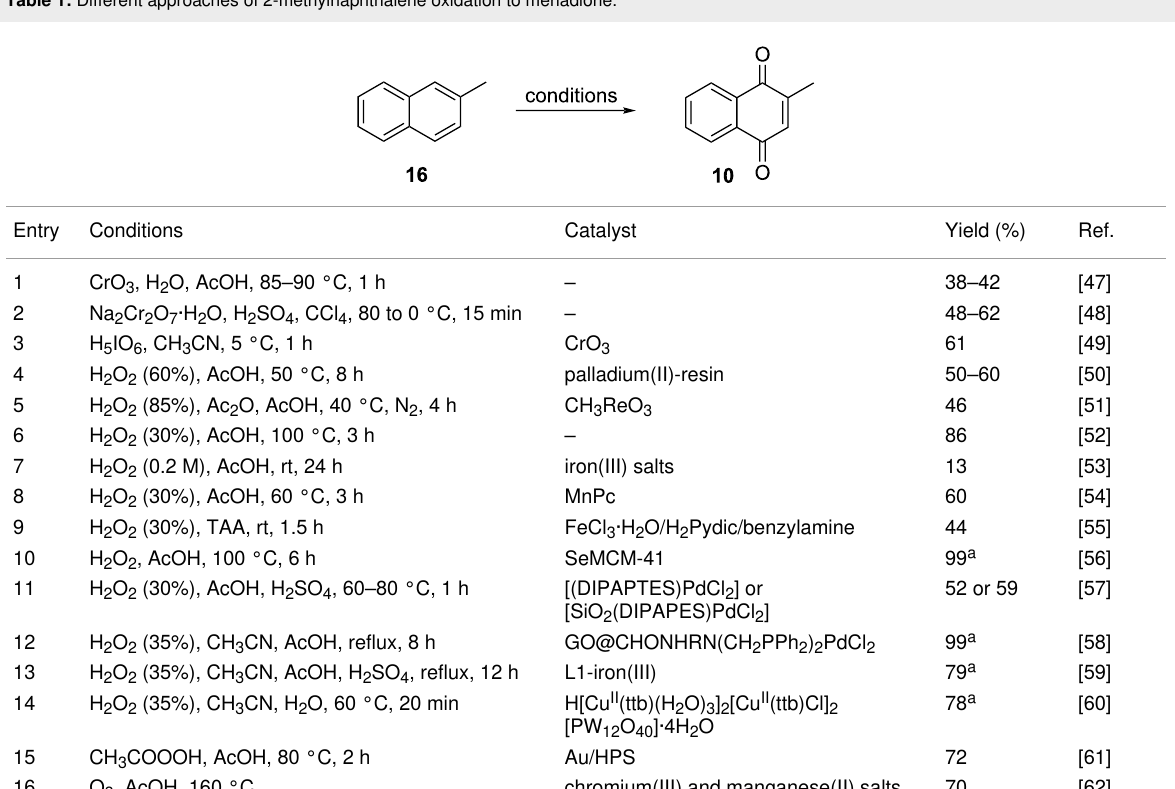
Table 1: Different approaches of 2-methylnaphthalene oxidation to